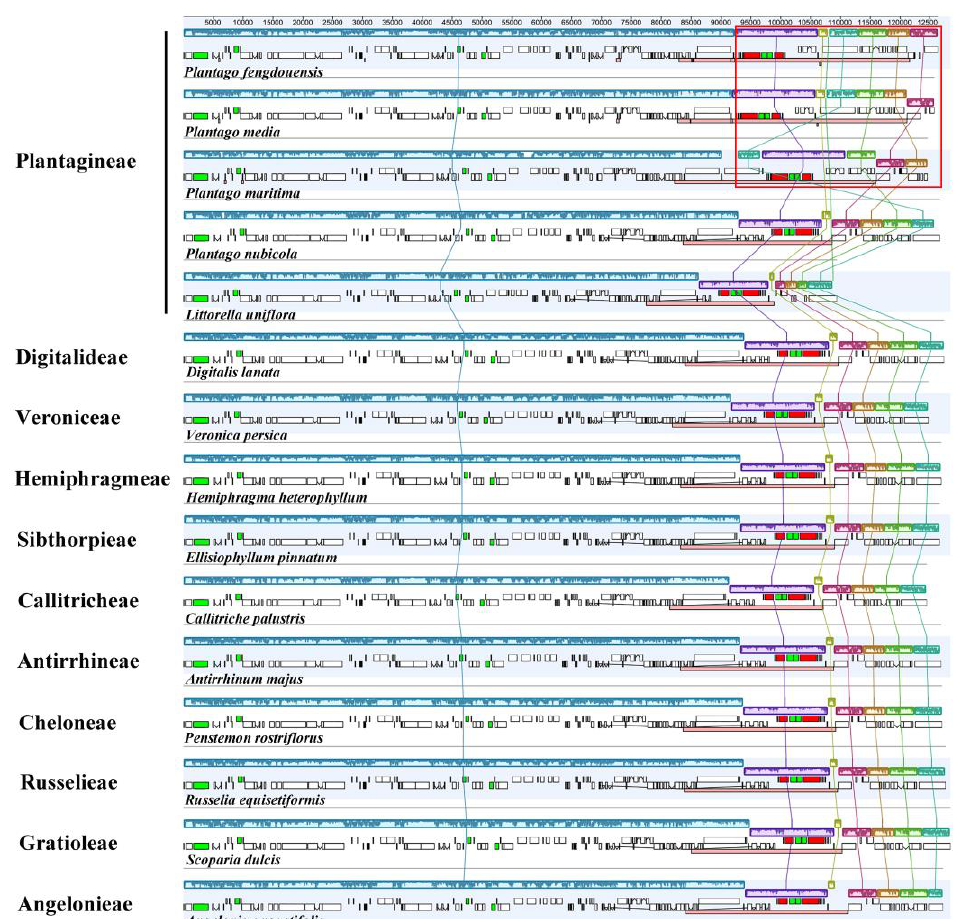
Figure 3. Comparison of plastomes from 15 representative species of Plantaginaceae using the MAUVE algorithm. Rectangular blocks of the same color indicate collinear regions of sequences and the histograms within each block indicate the degree of sequence similarity. The pink blocks indicate the IR regions. The red frame indicates the areas of structural rearrangement, including translocations and inversions (see Figure S1 for more details).